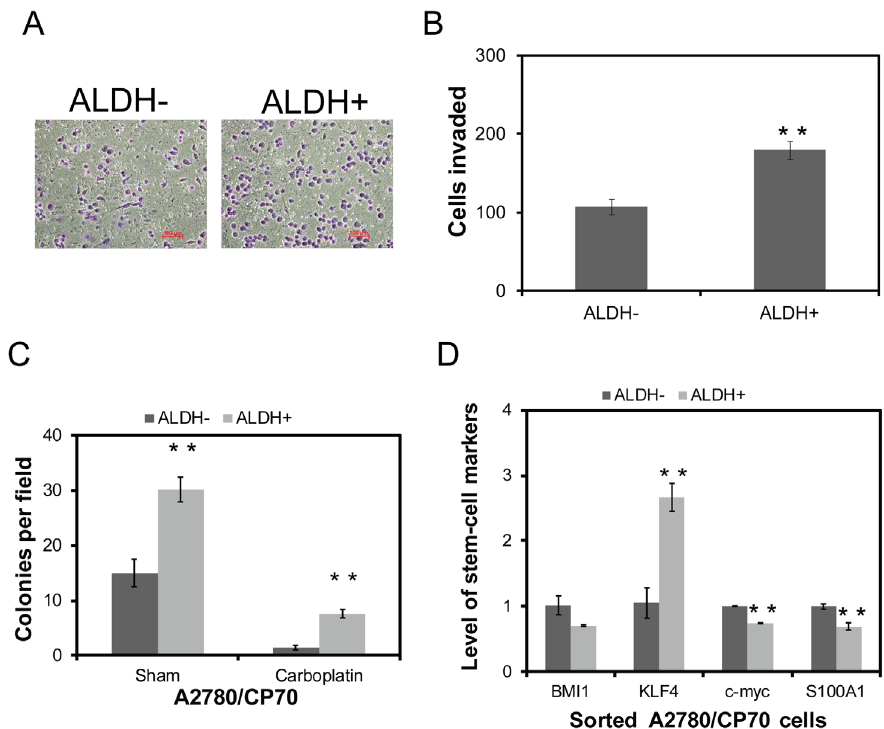
Figure 3. ALDH + phenotypes demonstrate cancer stem cell properties. A2780/CP70 cells were sorted into ALDH 2 and ALDH + phenotypes and evaluated for their abilities for invasion using Matrigel invasion chambers (A), quantitative data as represented (B) and colony formation potential in the presence and absence of carboplatin (20 m M) were assessed using soft agar colony formation assays (C). In order to determine possible mechanism for cancer stem cell characteristics in ALDH + cells, we evaluated multiple markers of ‘‘stemness’’. A2780/CP70 cells were sorted into ALDH 2 and ALDH + phenotypes, total RNA was isolated, cDNA was prepared and real-time quantitative RT-PCR was performed (D). **indicates statistical significance ( p ,